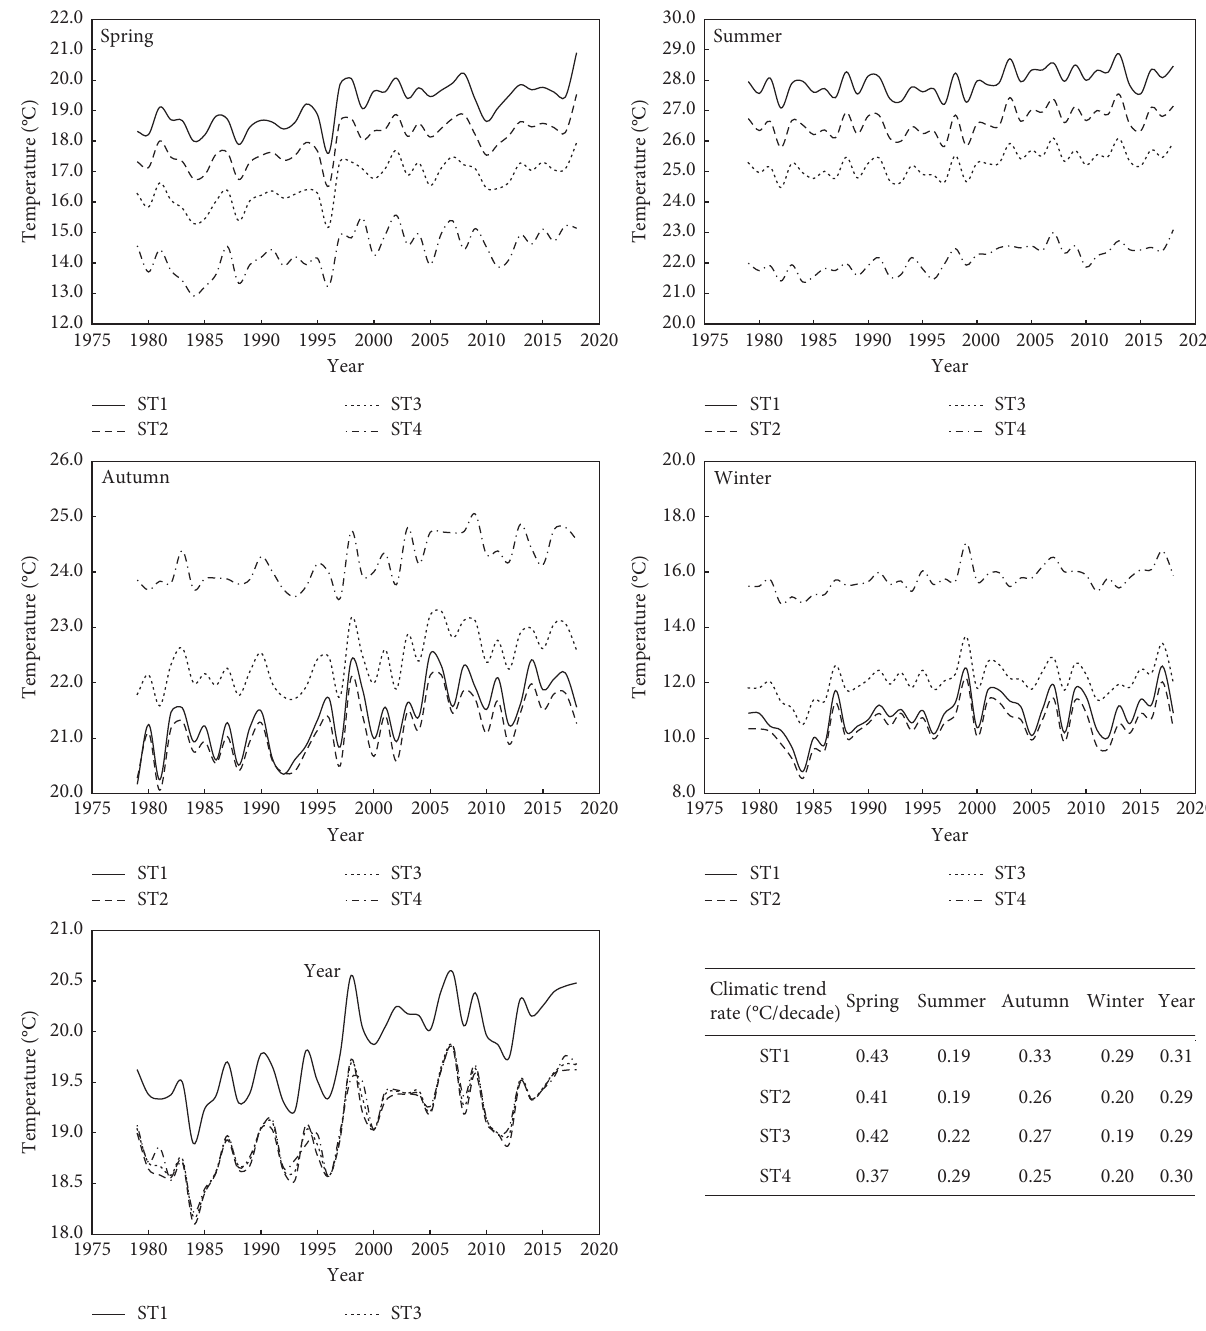
Figure 4: Changes in seasonal and annual soil temperatures over the Poyang Lake